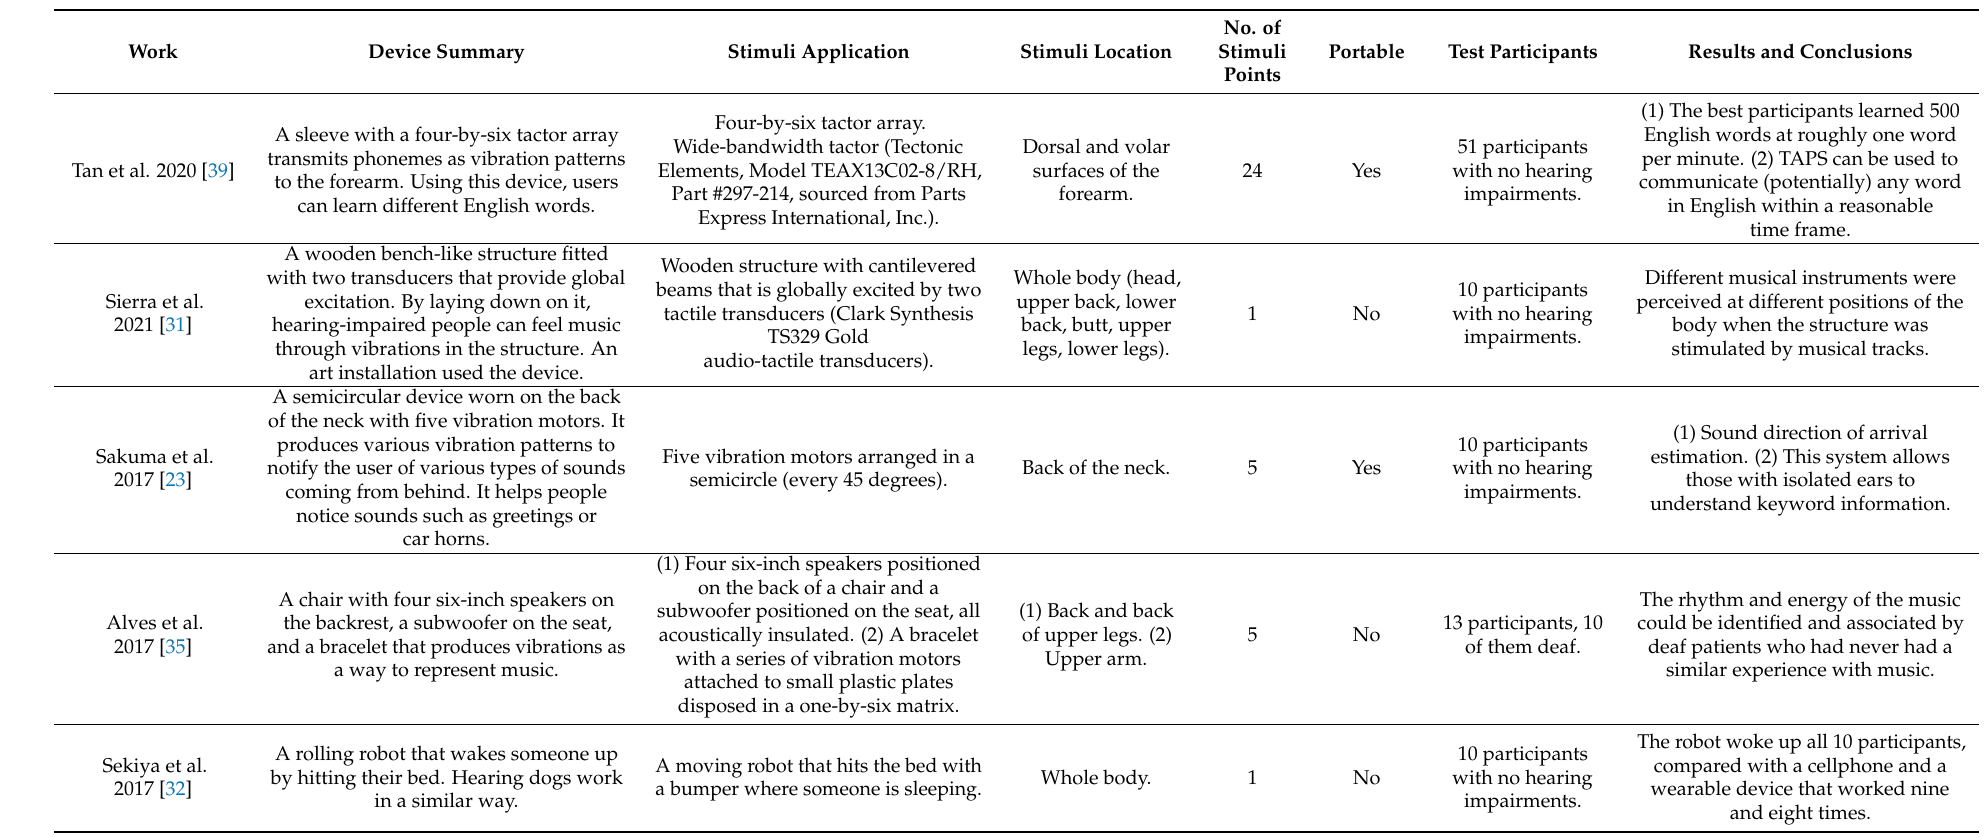
Table A2. Summarized information extracted from the selected papers and the haptic devices presented in